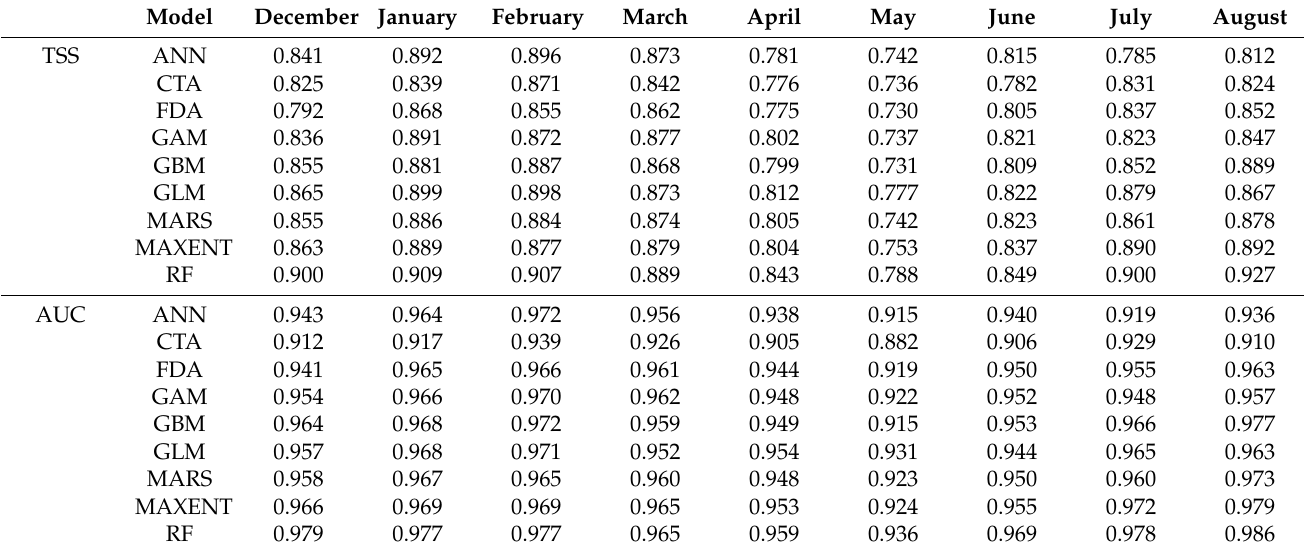
Table 4. TSS and AUC of the ensemble models. The AUC value is between 0.5 and 1, while the TSS value is between − 1 and 1.